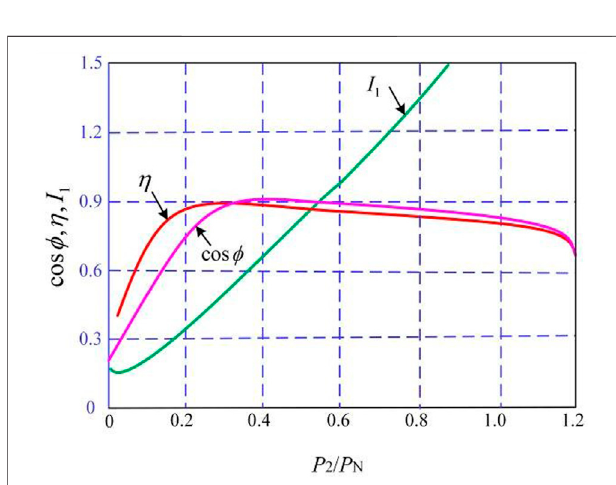
FIGURE 12 | Prototype-operating characteristics in liquid nitrogen ( − 196 ° C).